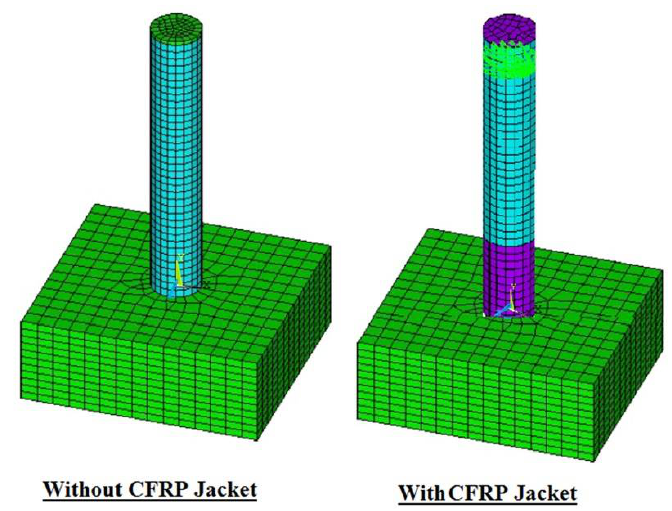
Figure 2. Meshing of the CFT specimens with and without CFRP wrapping.